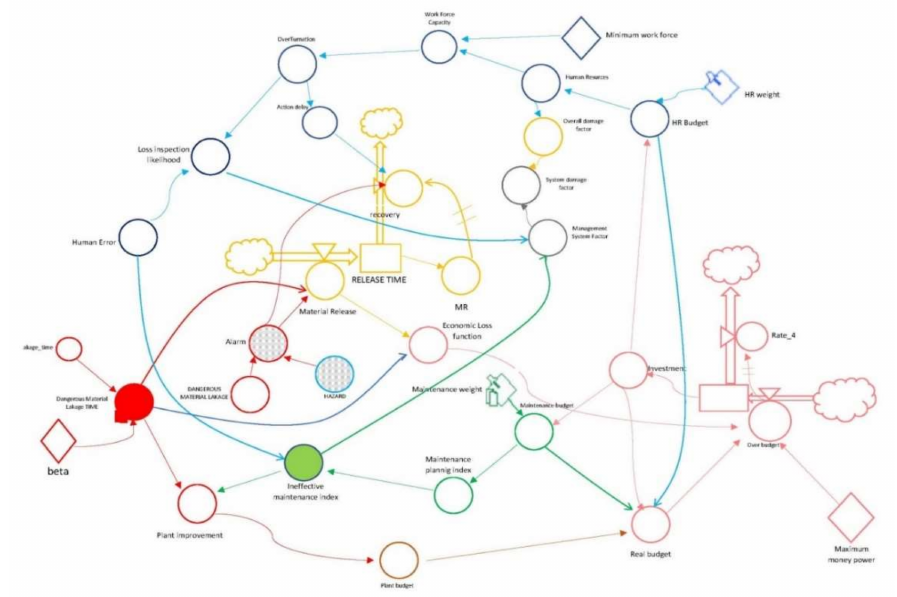
Figure 3. System dynamics diagram—management loops.